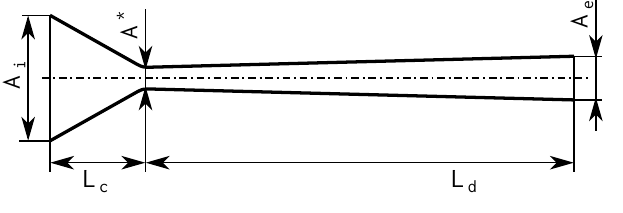
Table 1. Geometrical details of the nozzles.